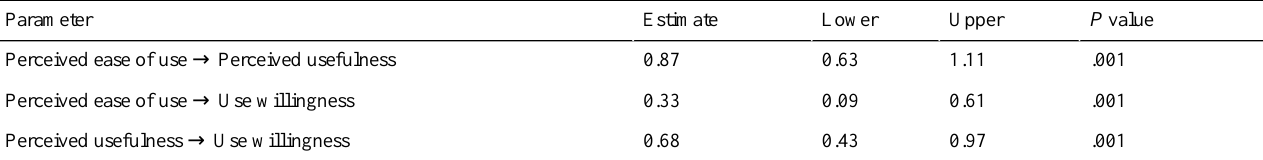
Table 5. Standardized coefficients and significance of direct